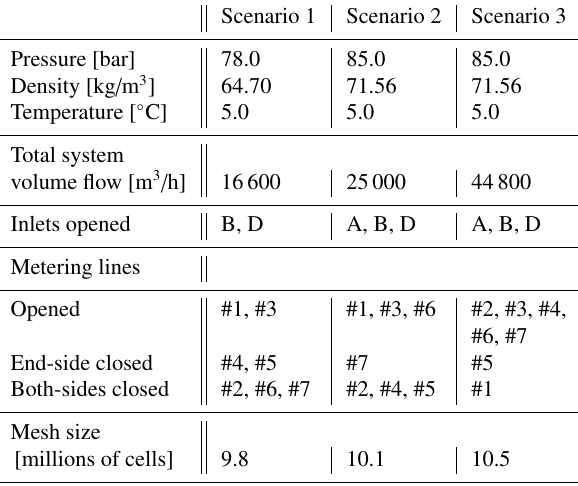
Table 1: Three operational scenarios description Table 2: Mass flow [kg / s] in metering runs